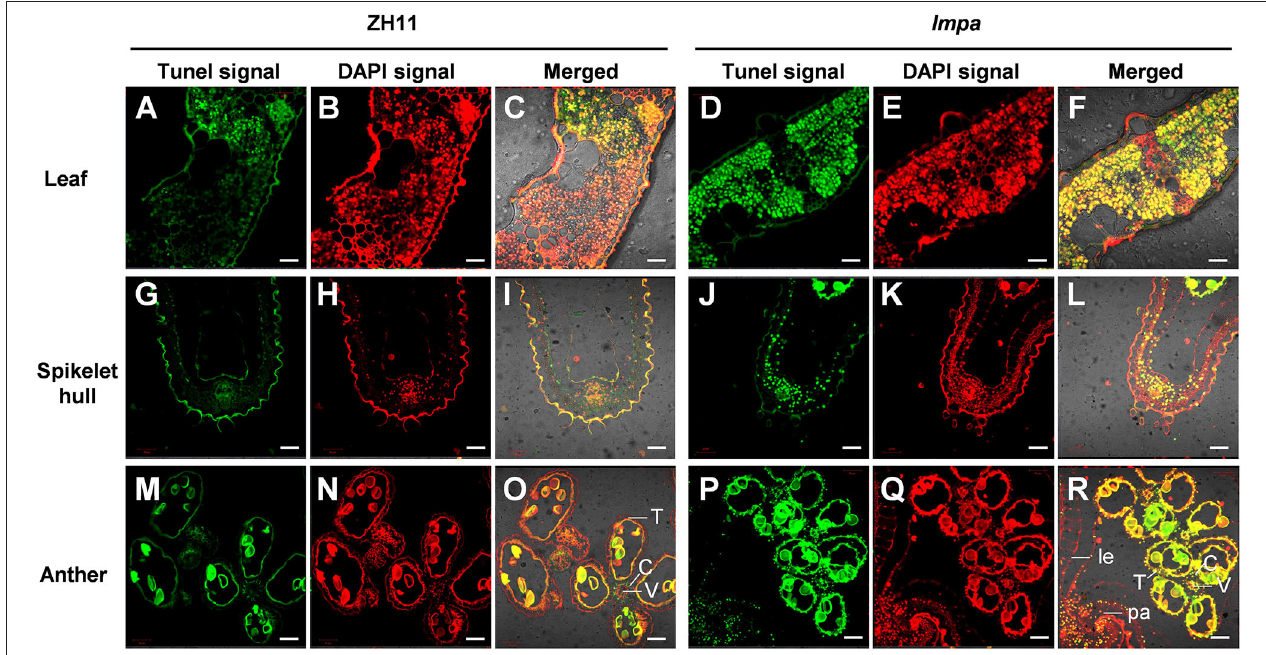
FIGURE 3 | Detection of DNA fragmentation by the TUNEL assay. (A–F) TUNEL assay of leaves in WT (A–C) and lmpa mutant (D–F) . (G–L) TUNEL assay of apical spikelet hull cells in WT (G–I) and in lmpa (J–L) . (M–R) TUNEL assay of apical spikelet anthers in WT (M–O) and in lmpa (P–R) . TUNEL-positive signals are indicated by the green fluorescence of fluorescein, and nuclei fluoresce deep red signals due to counterstaining with DAPI. le, lemma; pa, palea; C, connective tissue; V, vascular bundle cells; T, tapetum. Bars = 20 µ m in (A–L) , 50 µ m in (M–R)